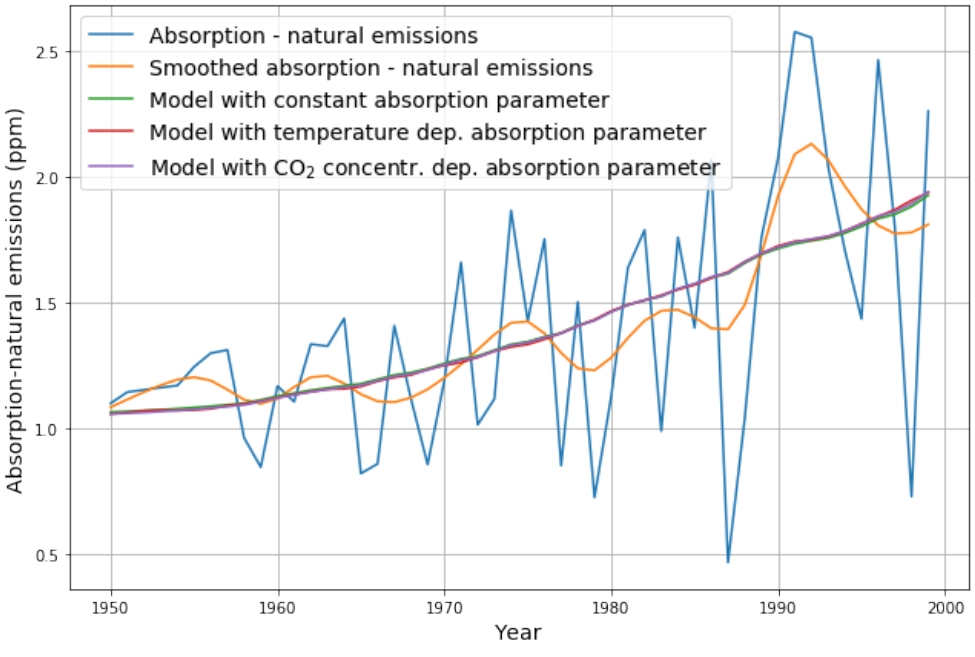
Figure 5. Comparing absorption models